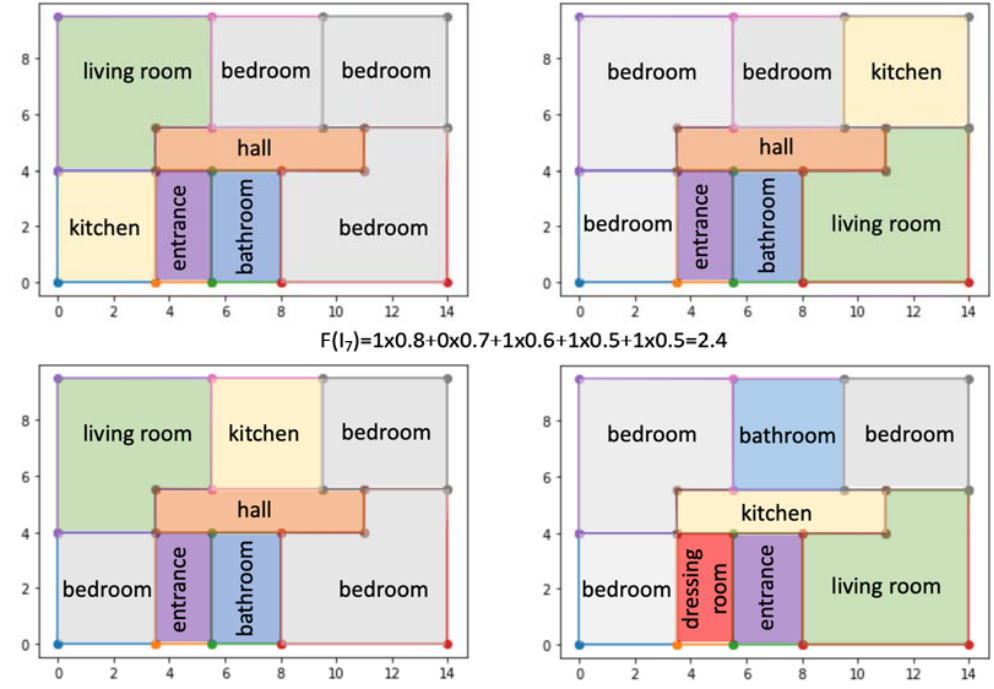
Figure 11. Four different assignments of labels determining the functions for a single floor plan I 7 from Figure